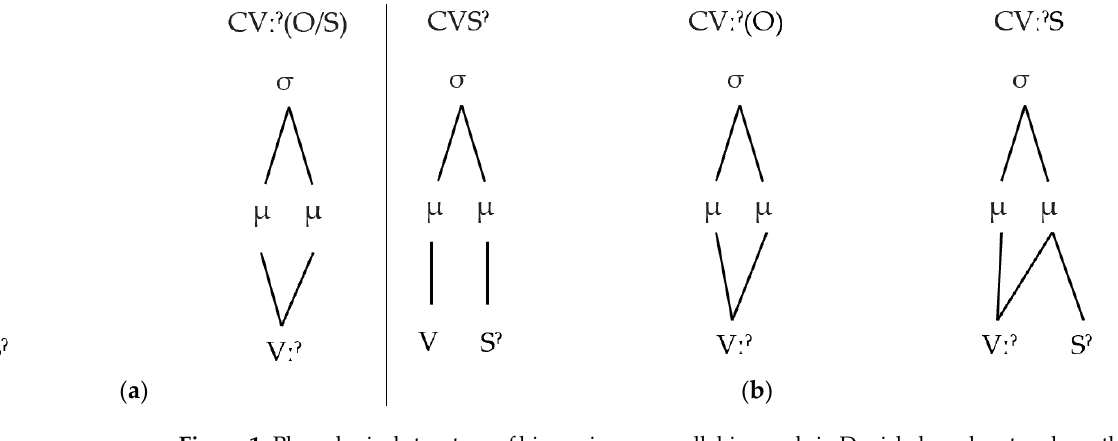
Figure 1. Phonological structure of bimoraic, monosyllabic words in Danish, based on two hypotheses of moraic formulation. ( a ) The moraic hypothesis, based on morae formulation in Basbøll (1985, 2005). In CVS ˀ words, stød is proposed to time to the coda sonorant. In CV ːˀ , CV ːˀ O, and CV ːˀ S words, stød is proposed to start in the middle of the long vowel and end at the end of the long vowel. ( b ) The shared mora hypothesis. In CVS ˀ words, stød is proposed to time to the coda sonorant. In CV ːˀ and CV ːˀ O words, stød is proposed to start in the middle of the long vowel and end at the end of the long vowel. For CV ːˀ S words, the second mora is shared by the long vowel and coda sonorant, and stød is proposed to start in the middle of the sonorant rhyme and end at the end of the coda sonorant.